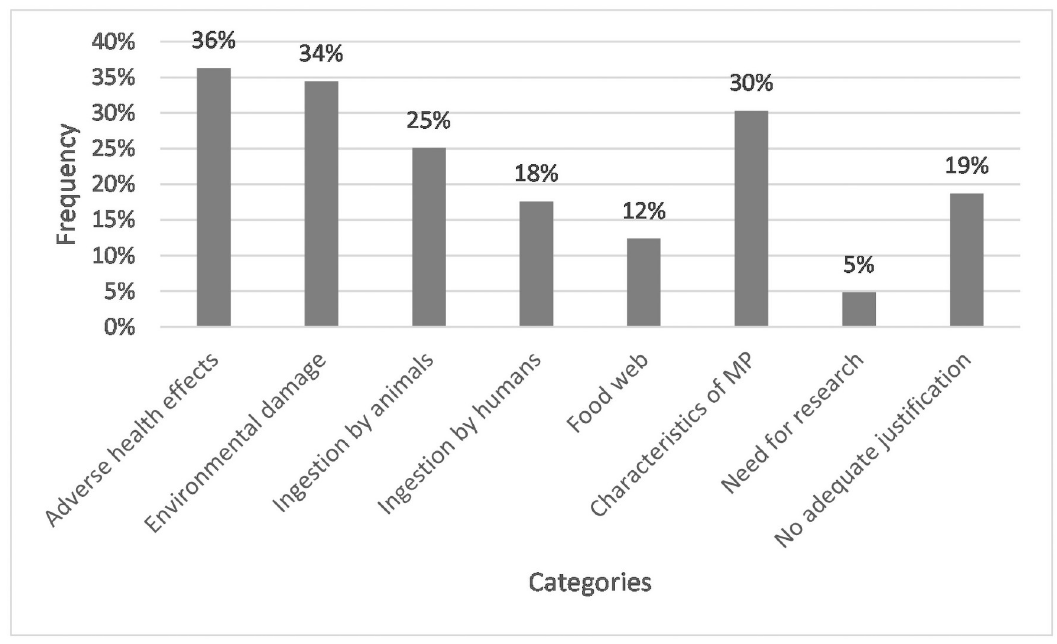
Fig 3. Frequencies of students’ answers assigned to the corresponding categories for Q5b: “Justify your decision [of Q5a].” N = 267. Open question with categories formed from students’ answers.